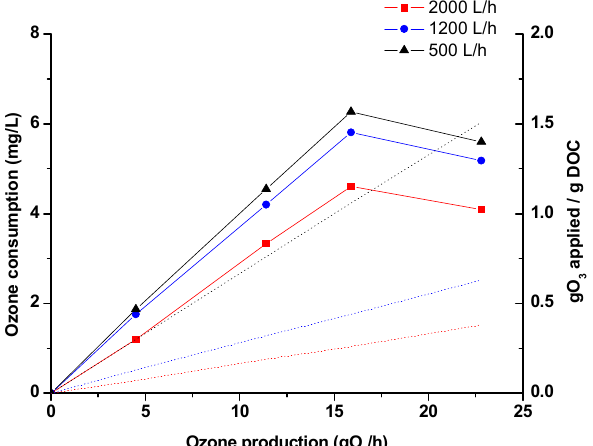
Figure 2. Ozone consumption (straight line) and applied normalized ozone (dash line) under experimental conditions.